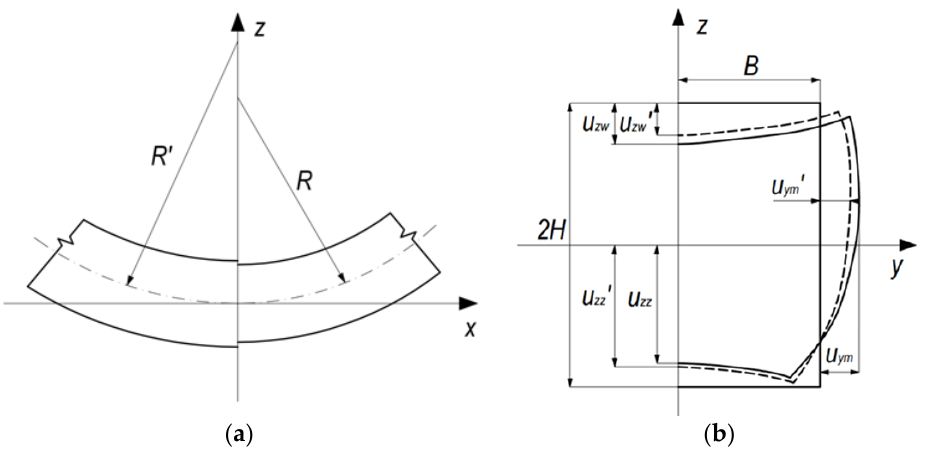
Figure 1. Bending radius ( a ) and characteristic tube dimensions and displacements of the deformed cross section ( b ) in the active bending phase and after unloading (springback).